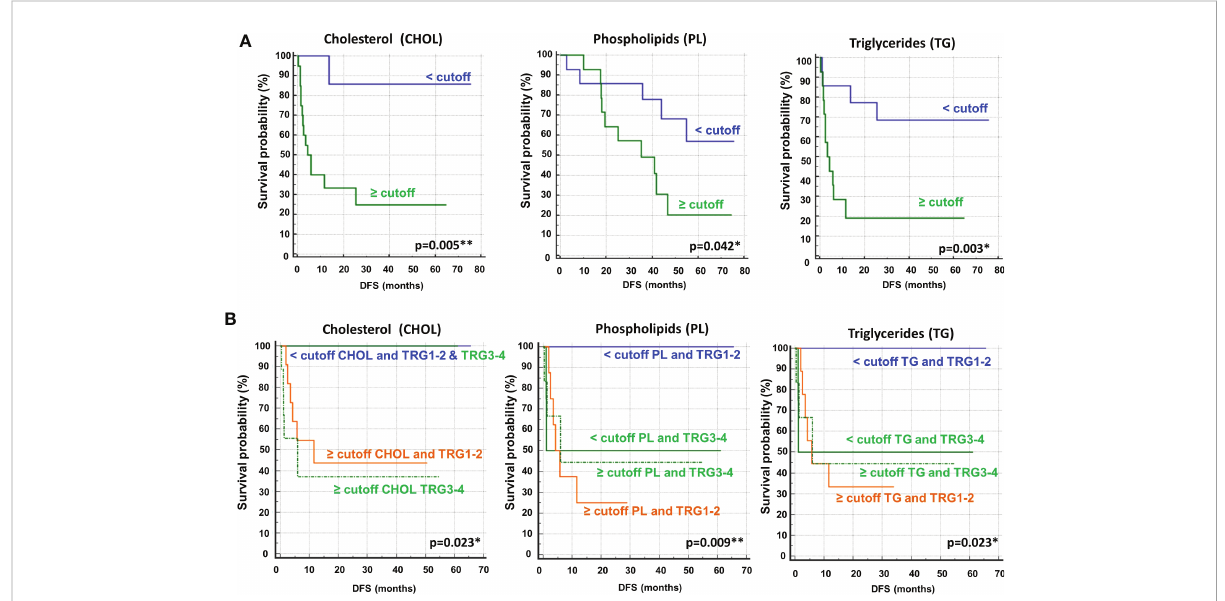
FIGURE 7 (A) Kaplan – Meier curves of disease free survival (DFS) accordingly to cholesterol (CHOL), phospholipids (PL) and triglycerides (TG). (B) Kaplan – Meier curves of DFS accordingly to tumor regression grade (TRG) alone (log-rank p=0.036) and in combination with CHOL, Pl or TG (log-rank p-values are reported). * and ** symbols indicate p-values < 0.05 and < 0.01,